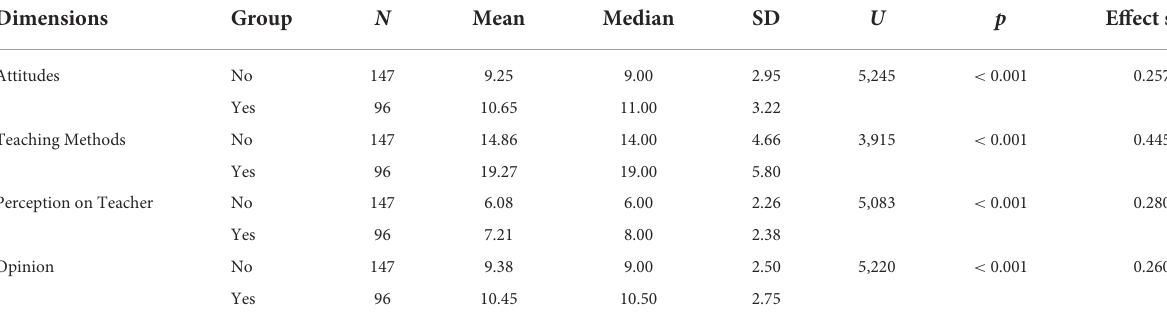
TABLE 7 Mann–Whitney U results according to usage of technology.